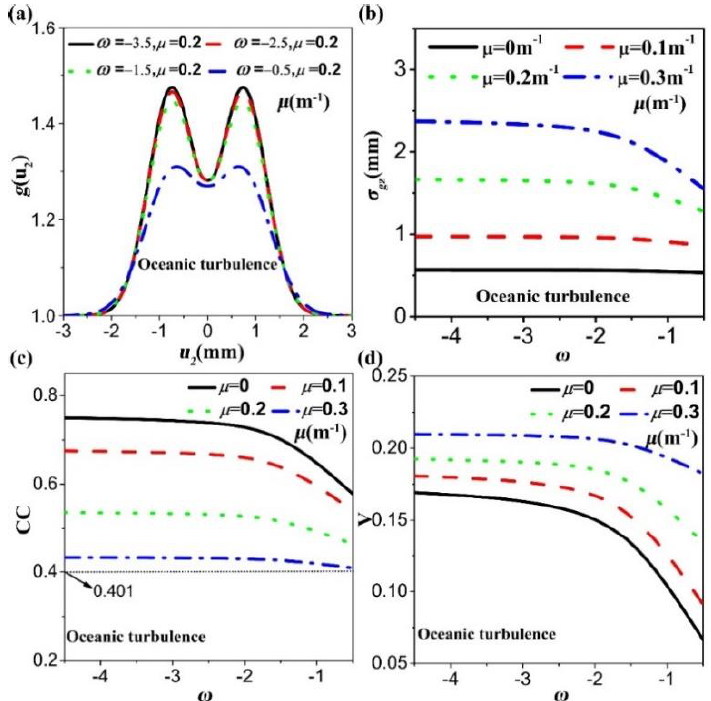
Figure 5. ( a ) Image of the double slits; ( b ) Change of coherence width with the parameter ε ; ( c ) Variation of the quality of the image (CC) with the parameter ε ; ( d ) Variation of the visibility of image ( V ) with the parameter ε . Appl. Sci. 2019 , 9 , x FOR PEER REVIEW